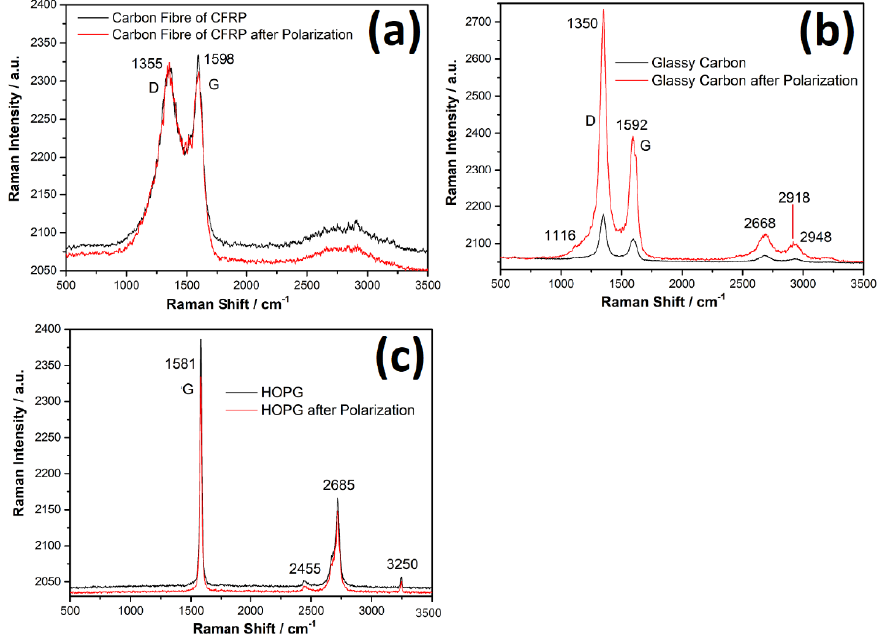
Figure 8 . Confocal Raman spectra of ( a ) carbon fiber surfaces in CFRP, ( b ) glassy carbon surfaces, and ( c ) HOPG surfaces before and after 1 h polarization in 50 mM NaCl at − 1000 mV SCE , respectively.